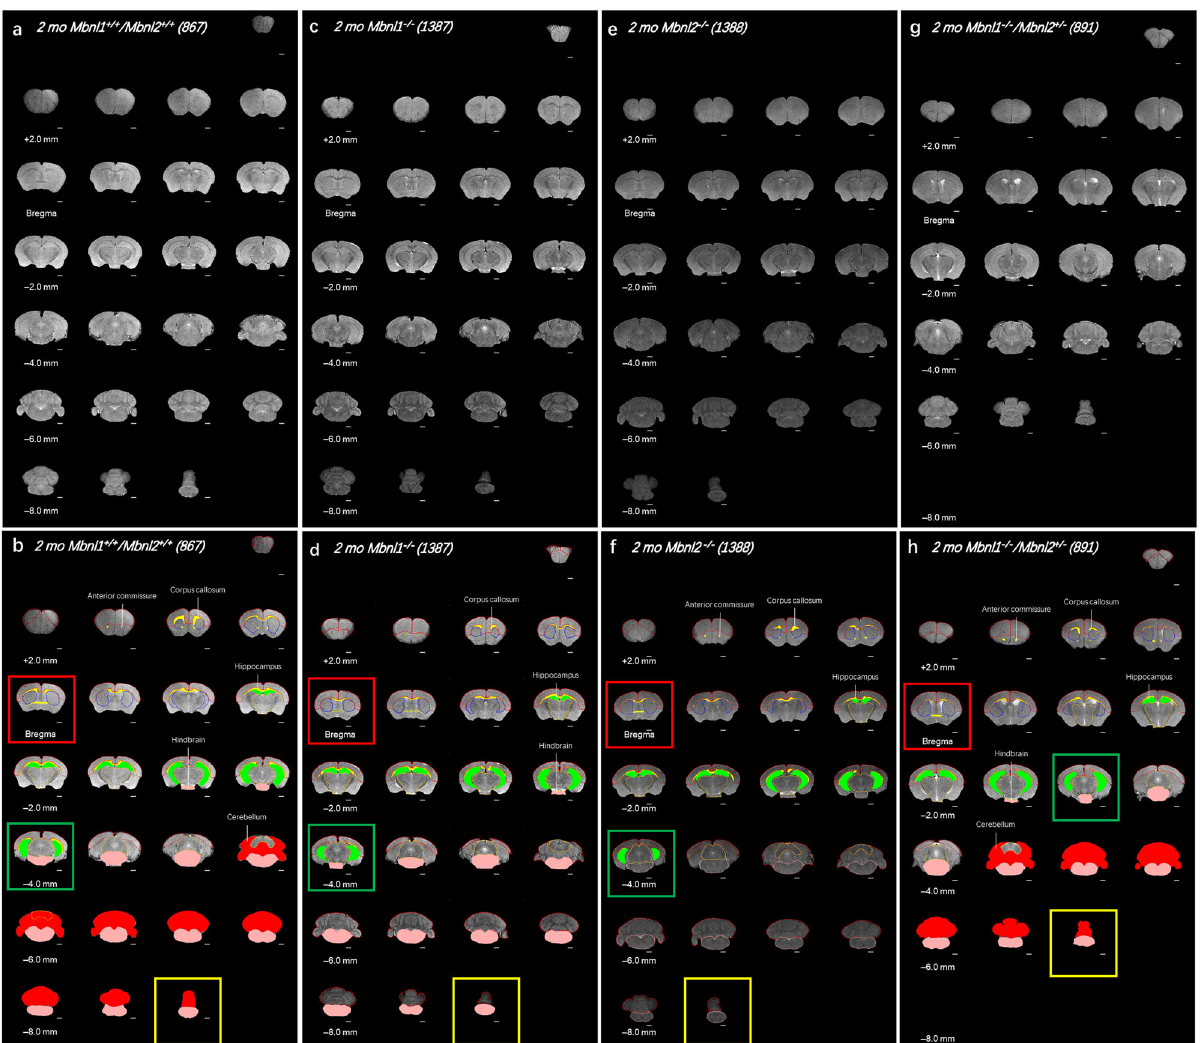
Fig. 4 Whole-brain FSE T2w MRIs show Mbnl1/2 genotype-dependent regional volume alterations. a , c , e , g A montage of slices of extracted whole brains of representative 2-mo Mbnl1 + / + /Mbnl2 + / + (wild-type control) Mbnl1 − / − , Mbnl2 − / − , and Mbnl1 − / − /Mbnl2 + / − mice that underwent in vivo 2D FSE T2w MRIs, respectively, are shown. b , d , f , h Show regions of interest (ROI) manually drawn and color- fi lled as described in the Methods. Only ROIs that are signi fi cantly different from the control Mbnl1 + / + /Mbnl2 + / + brains are color- fi lled in the Mbnl1 + / + /Mbnl2 + / + , Mbnl1 − / − , Mbnl2 − / − , and Mbnl1 − / − /Mbnl2 + / − montages. Colored regions are white matter regions, which include the anterior commissure and corpus callosum/external capsule (yellow), and gray matter regions, which include the cerebellum (red), the hippocampus (green), and the hindbrain (pink). Calculated areas from the ROIs were multiplied by the image-slice thickness to generate ROI volumes shown in Figs. 5 – 7. The olfactory bulb was excluded in volume measurements. Slice positions were identi fi ed based on Bregma locations. The slice where the anterior commissure is connected between hemispheres approximates Bregma, which is de fi ned as 0.0 mm. Going from rostral to caudal slice positions, boxes indicate structural landmarks that include Bregma (red box), the last slice containing hippocampal regions (green box), and the end of the brain (yellow box). Slice thickness = 0.5 mm. Scale bar = 1